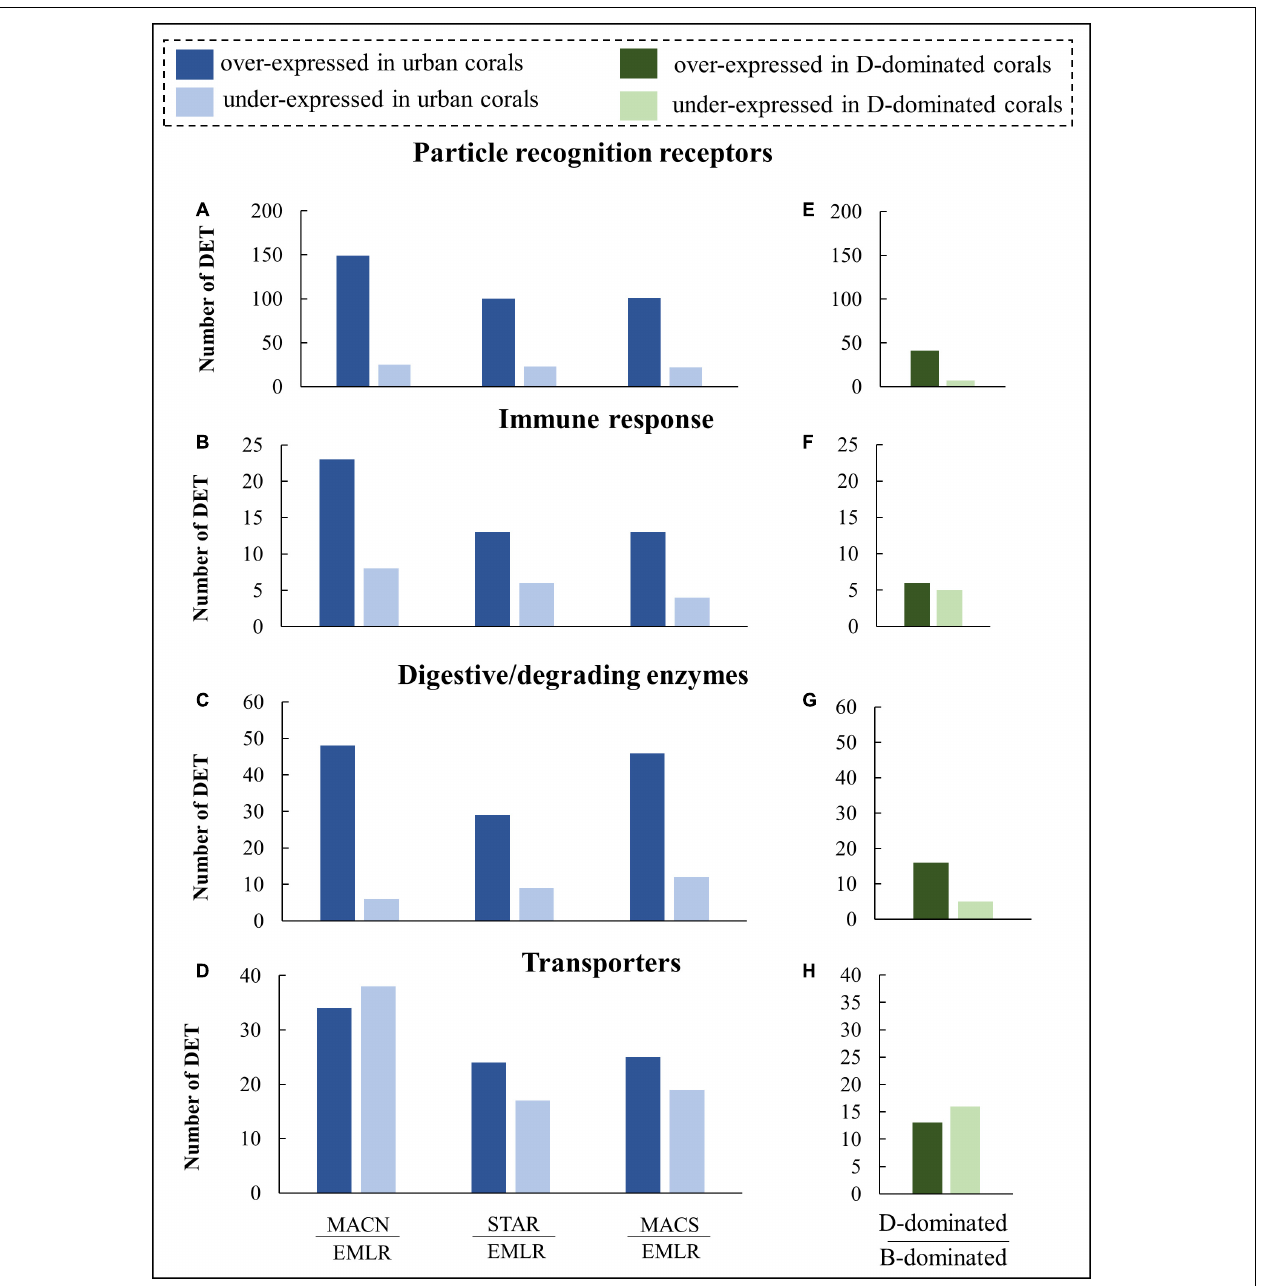
FIGURE 4 | Distribution of DETs in P. strigosa colonies grouped into four molecular-function categories. Differential expression analyses were made between colonies from each urban site (MACN, MACS, STAR) and colonies from an offshore reef (EMLR) which was used as a control (A–D) , and additional analysis was made between colonies ( n = 17) dominated by Durusdinium symbionts (D-dominated) in comparison to colonies ( n = 14) dominated by Breviolum (B-dominated) symbionts (E–H)